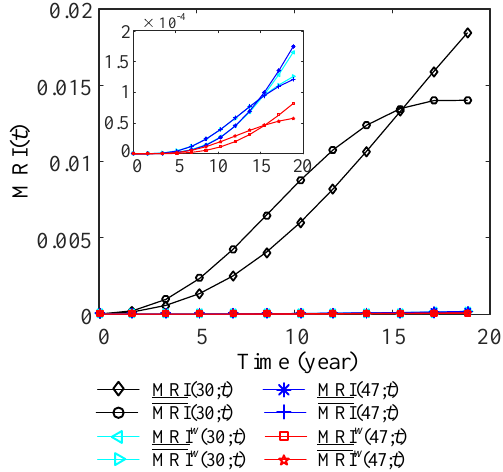
Figure 17. Lower and upper MRI of components 29 and 45.